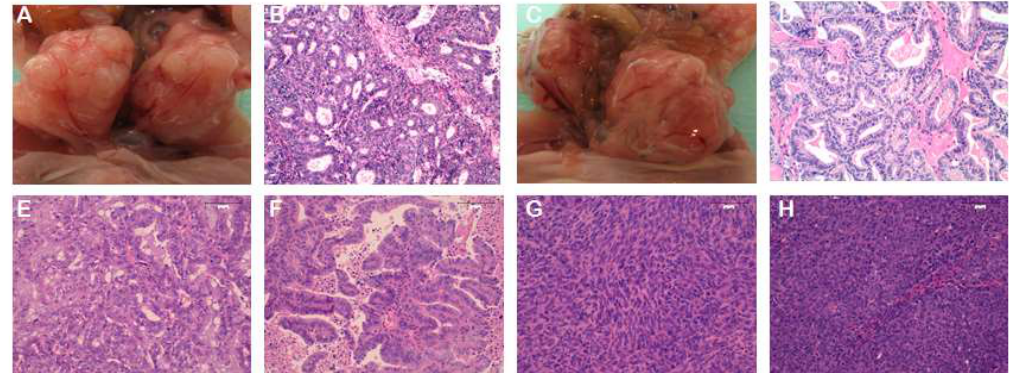
Figure 2. Representative PDX images from orthotopic ( A – D ) and heterotopic ( E – H ) models. ( A – D )